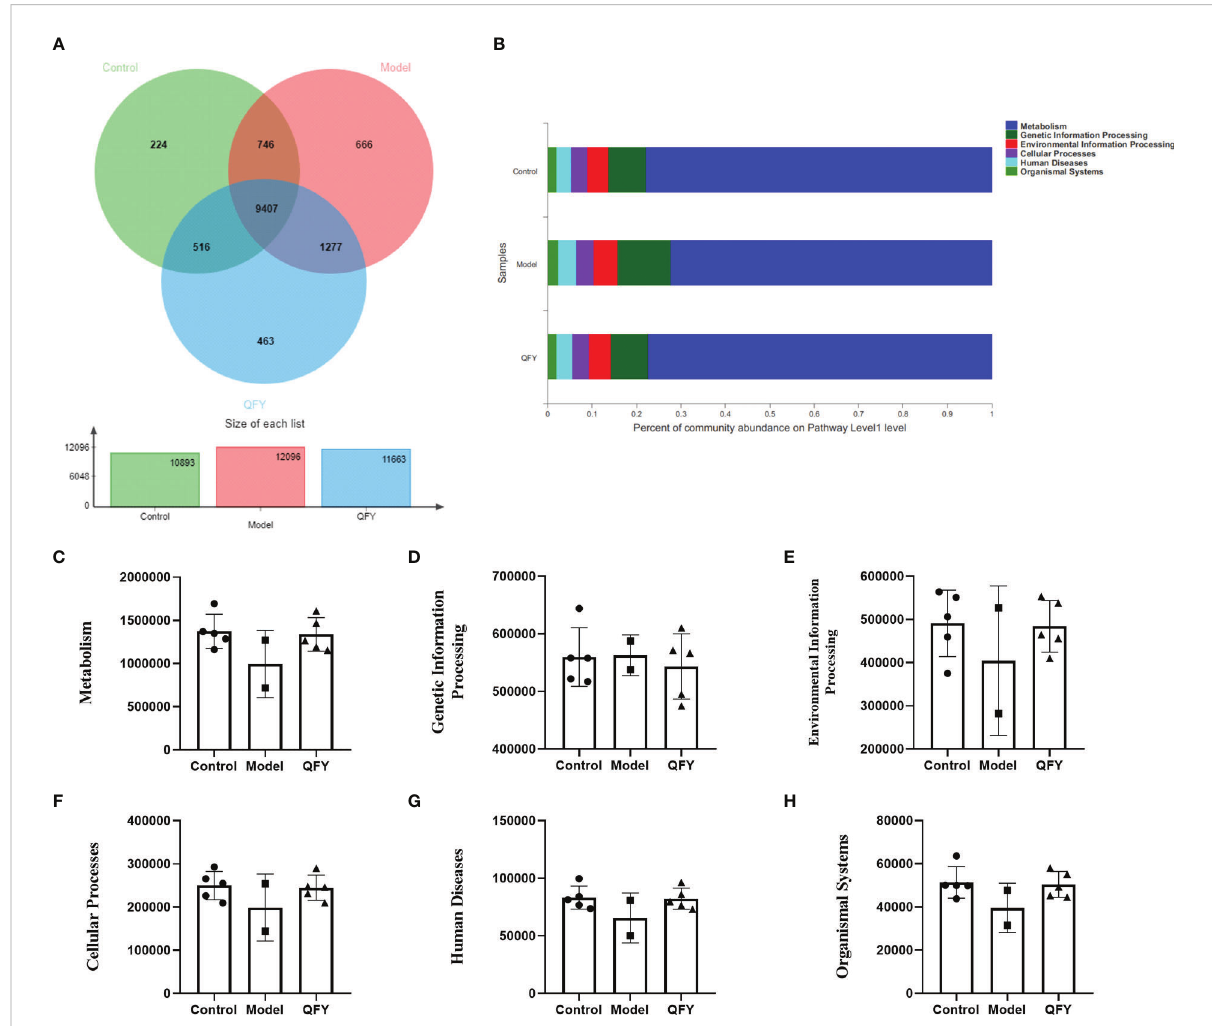
FIGURE 8 The effect of Qi-Fu-Yin on the function of KEGG of intestinal microorganisms in APP/PS1 transgenic mice (A) Functional pro fi les of each group in KEGG, (B) Percent of community abundance on pathway level 1, (C) Genes abundance in Metabolism, (D) Genes abundance in Genetic Information Processing, (E) Genes abundance in Environmental Information Processing, (F) Genes abundance in Cellular Processes, (G) Genes abundance in Human Diseases, (H) Genes abundance in Organismal Systems. Mean ± SD, n=2~5, unpaired Student ’ s- t test. GraphPad Prism 8.0.1